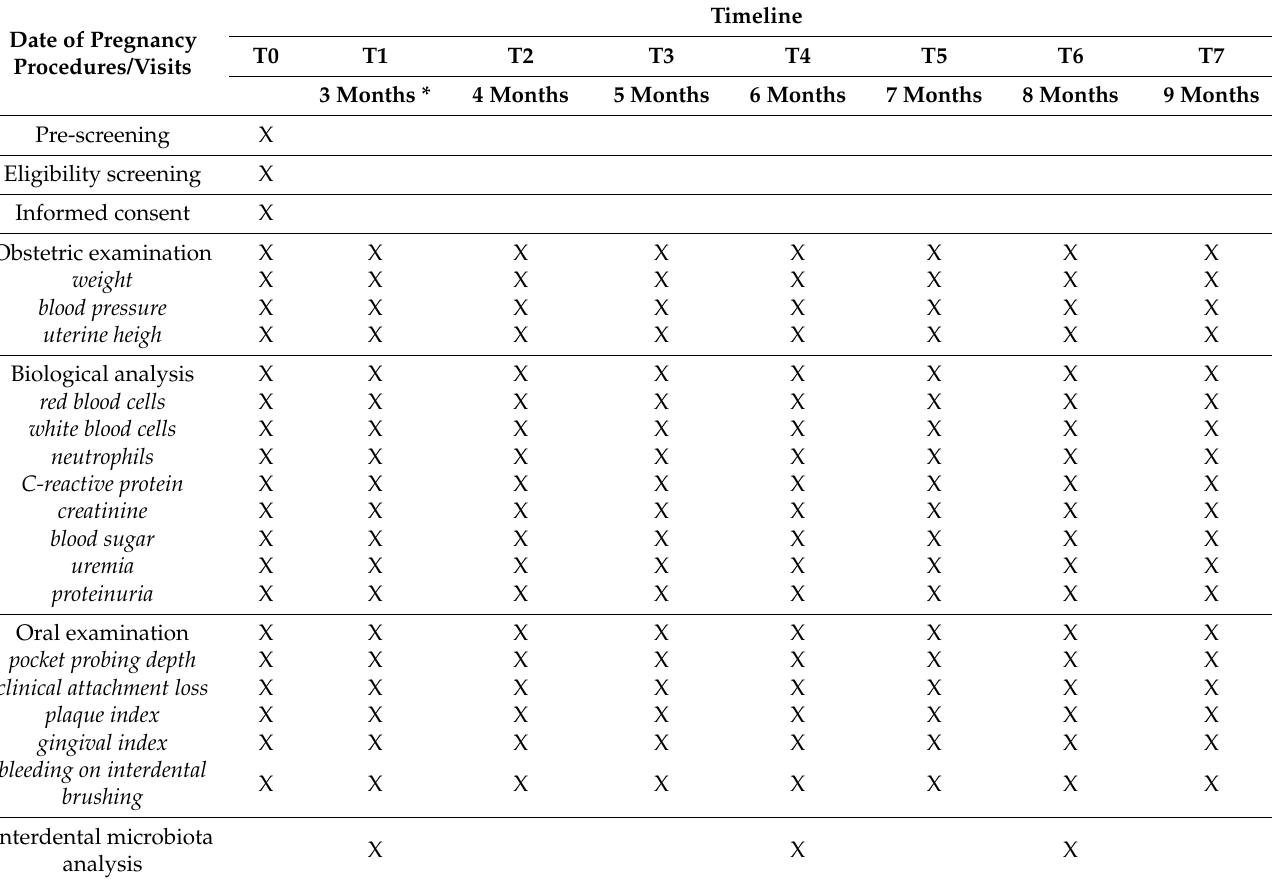
Table 1. Participation timeline of the